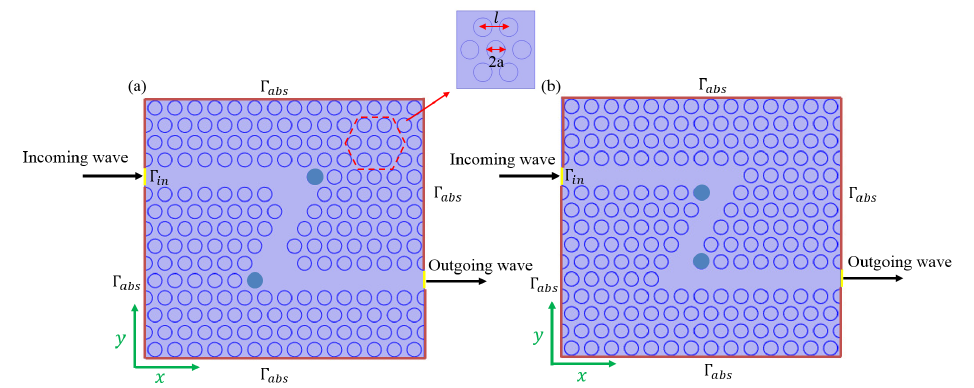
Figure 1. Z-bending waveguide in a finite PhC on triangle lattice: ( a ) straight Z waveguide; ( b ) curved Z waveguide. The radius of the air hole a = 251 nm, lattice constant l = 2.82 ∗ a . The dark blue air holes show the difference between the two structures. The red box magnifies the size of the structure. The structure exhibits aperiodic distribution in the xy -plane. Light enters the PhC from the incident port and leaves the PhC from the outgoing